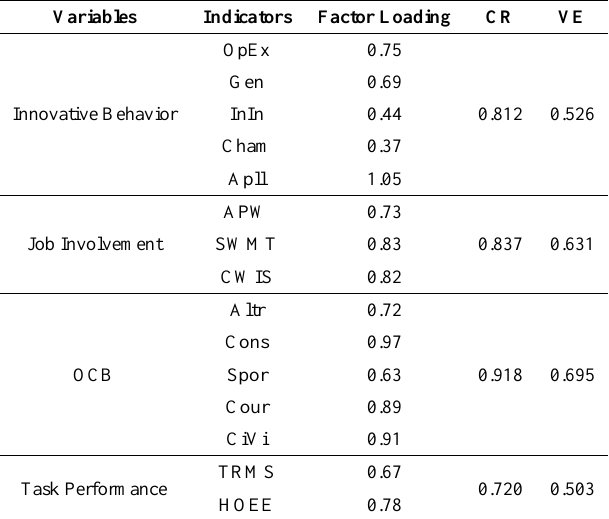
Table 2. The measurement model